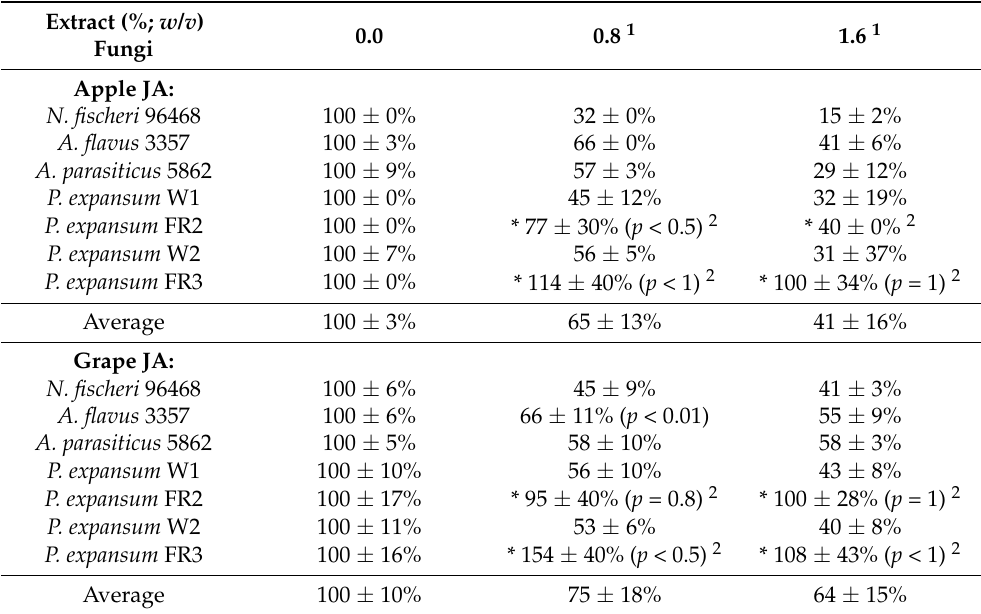
Table 3. Antifungal activity of TcM on apple or grape JA (% radial growth compared to no treatment